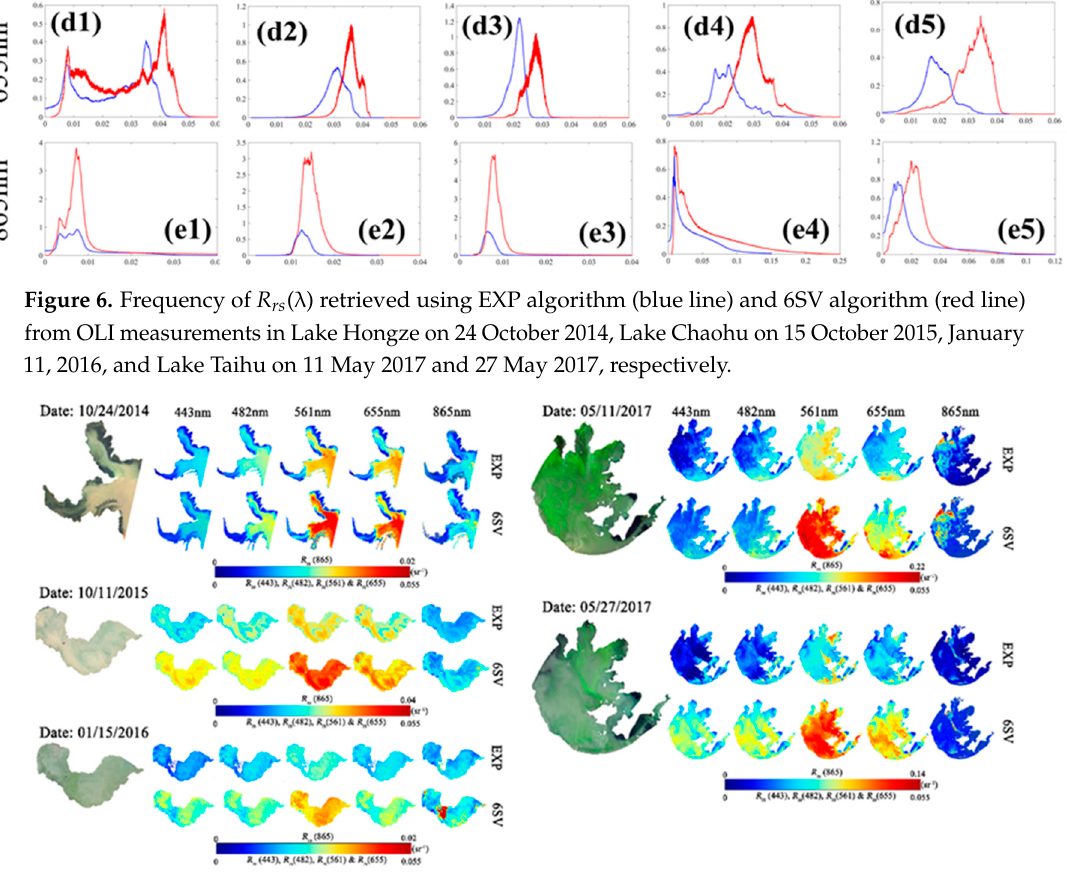
Figure 7. OLI true color image presenting, R rs ( λ ) for Lake Hongze on 24 October 2014, Lake Chaohu on 15 October 2015, 11 January 2016, and Lake Taihu on 11 May 2017 and 27 May 2017, respectively. R rs ( λ ) was derived by EXP and 6SV algorithm.